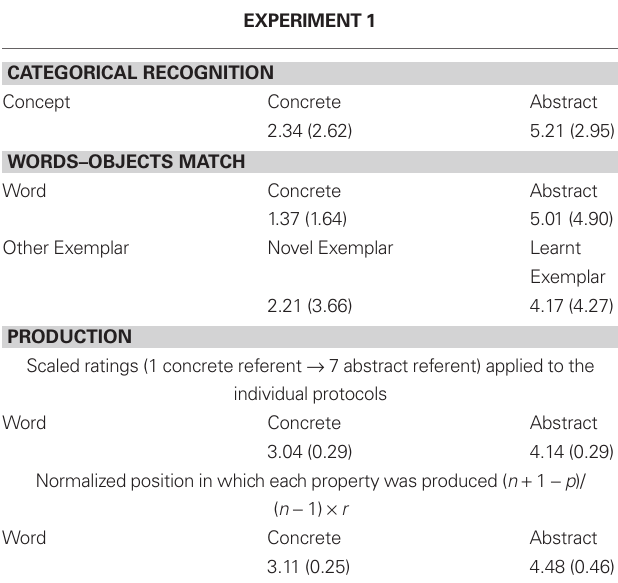
Table 1 | errors percentages and standard deviations (in parenthesis) for TeST 1 and TeST 2 of experiment 1. For TEST 3 we reported results on ratings’